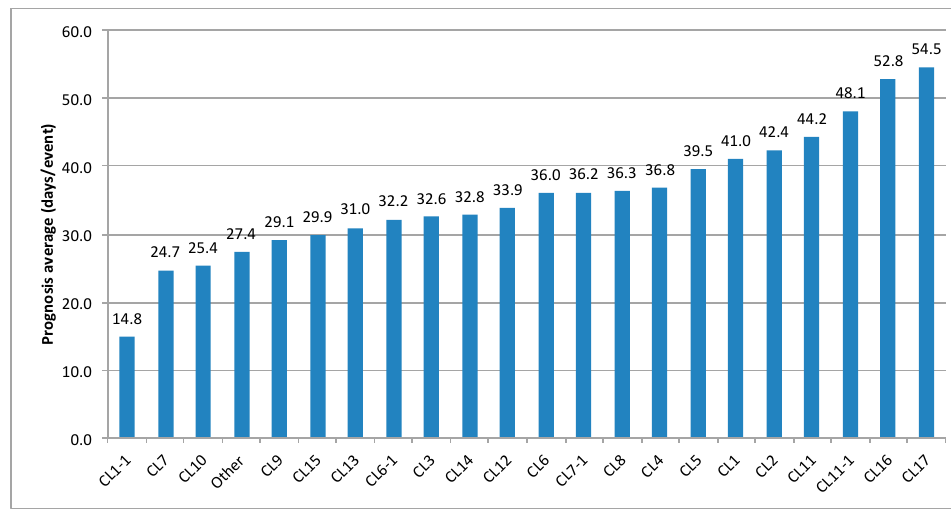
Figure 6. Average days of prognosis.